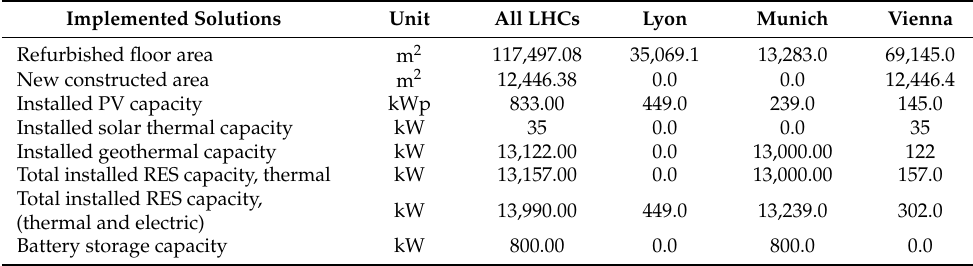
Table 2. Technical specifications of the implemented and monitored building and RES solutions of the three